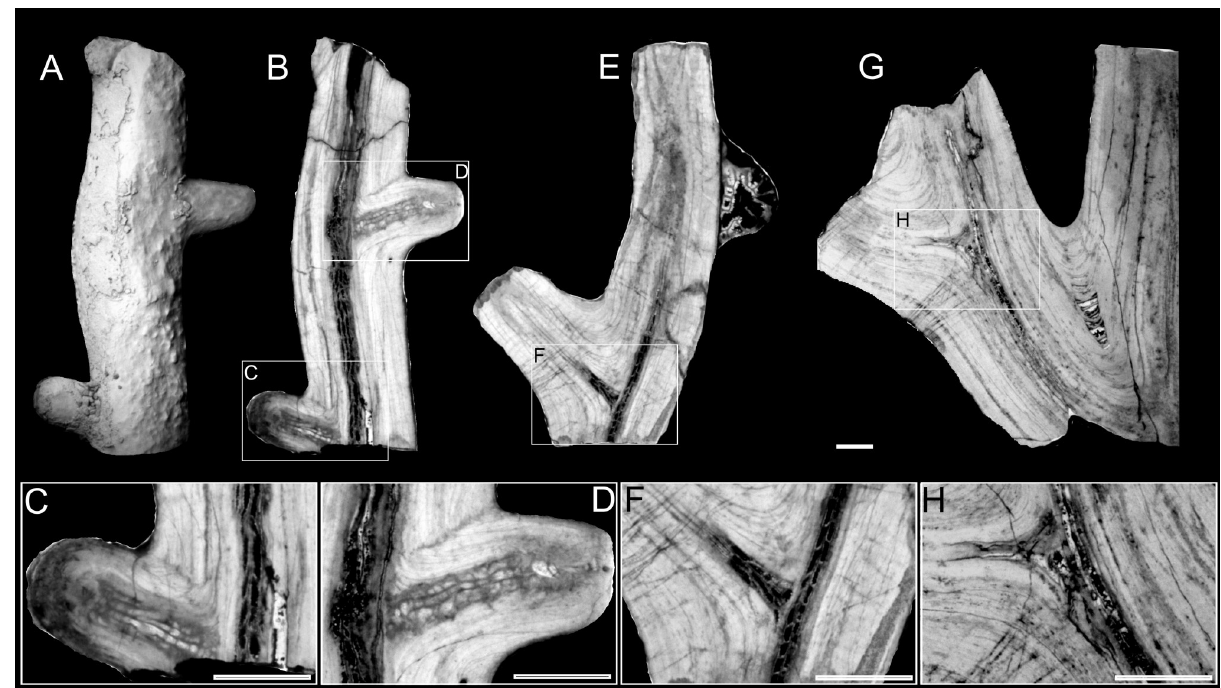
Fig 7. Broken fragments of colonies of Oligophylloides sp. showing the branching process. A-D–specimen UAM/He/B/025; E, F–specimen UAM/ He/B/026; G, H–specimen UAM/He/B/027. A–external view; B–longitudinal thin section through the central lumen; C, D–enlarged fragments of the thin section (B) showing branching points; E–longitudinal thin section through the central lumen; F–enlarged fragment of the thin section (E) showing branching point; G–longitudinal thin section through the central lumen; H–enlarged fragment of the thin section (G) showing branching point. Scale bars 2